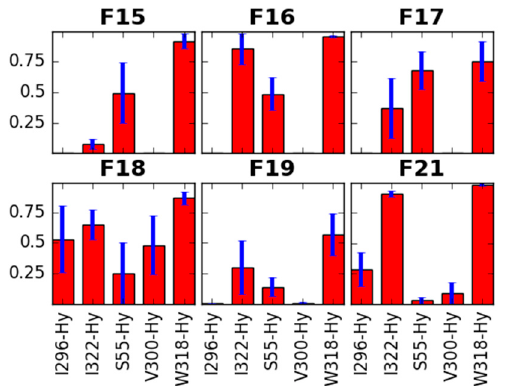
Figure 8. Interactions of the 4-axial substituent with the receptor residues. Red bars represent the mean frequency of contacts with a particular residue, and blue bars show standard error of the mean. Data are collected from last 10 ns of production in 3 replicas. In x -axis label given is the residue’s name and number as well as type of the contact (Hb—hydrogen bond, Hy—hydrophobic, A—aromatic). As to the outliers mentioned at the beginning of this section ( F14RRS , F14SRS , F20RS ), we